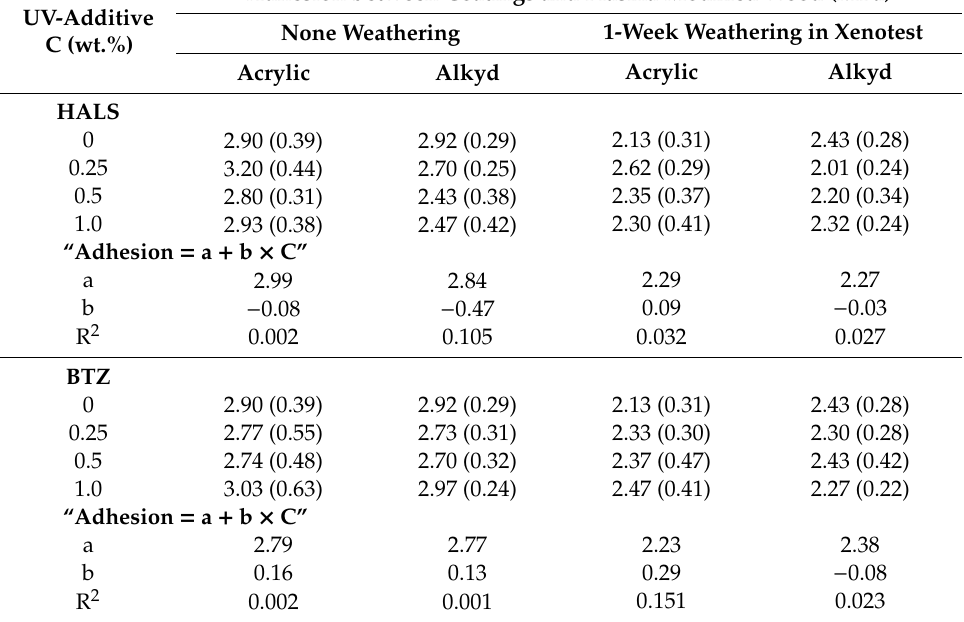
Table 1. No e ff ect of the hindered amine light stabilizer (HALS) and hydroxyphenyl-benzotriazoles (BTZ) used in the role of UV-additives on the adhesion strength between the coating (acrylic or alkyd) and the plasma modified Norway spruce wood—evaluation at none and 1 week artificial weathering—confirmed by the small coe ffi cients of determination R 2 from 0.001 to 0.151 for the linear correlations “Adhesion = a + b ×